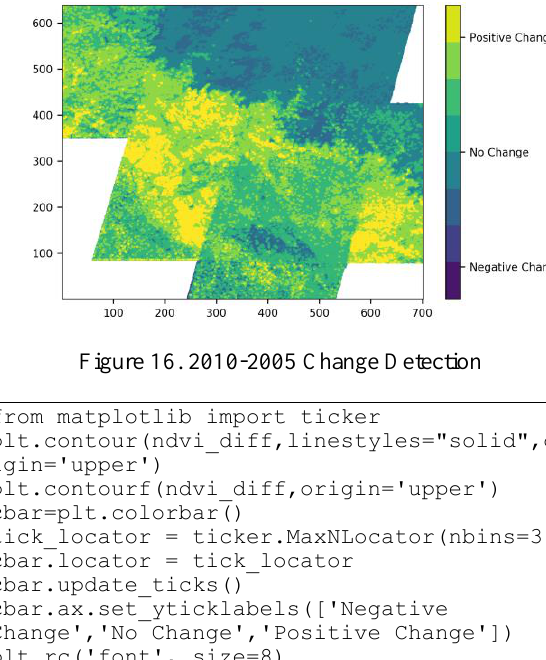
15 depicting the pixel counts of band 4 and NDVI values and plot the datasets operations.